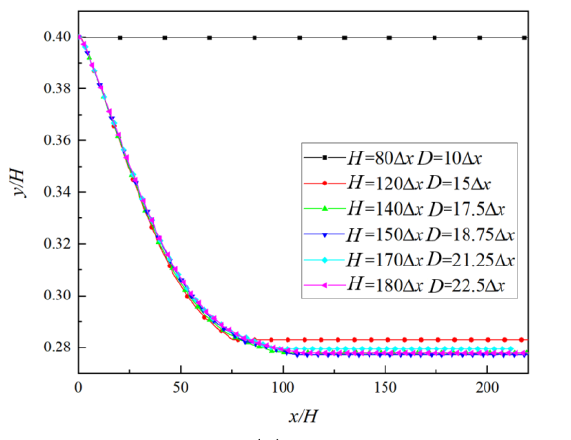
8 of 16 Figure 3. Comparison of trajectories of two analytical solutions of velocity profile, particles in a simple shear flow. 3.3. Grid and Compute-Domain Independence The moving boundary is at the midpoint of the solid interior lattice and the fluid